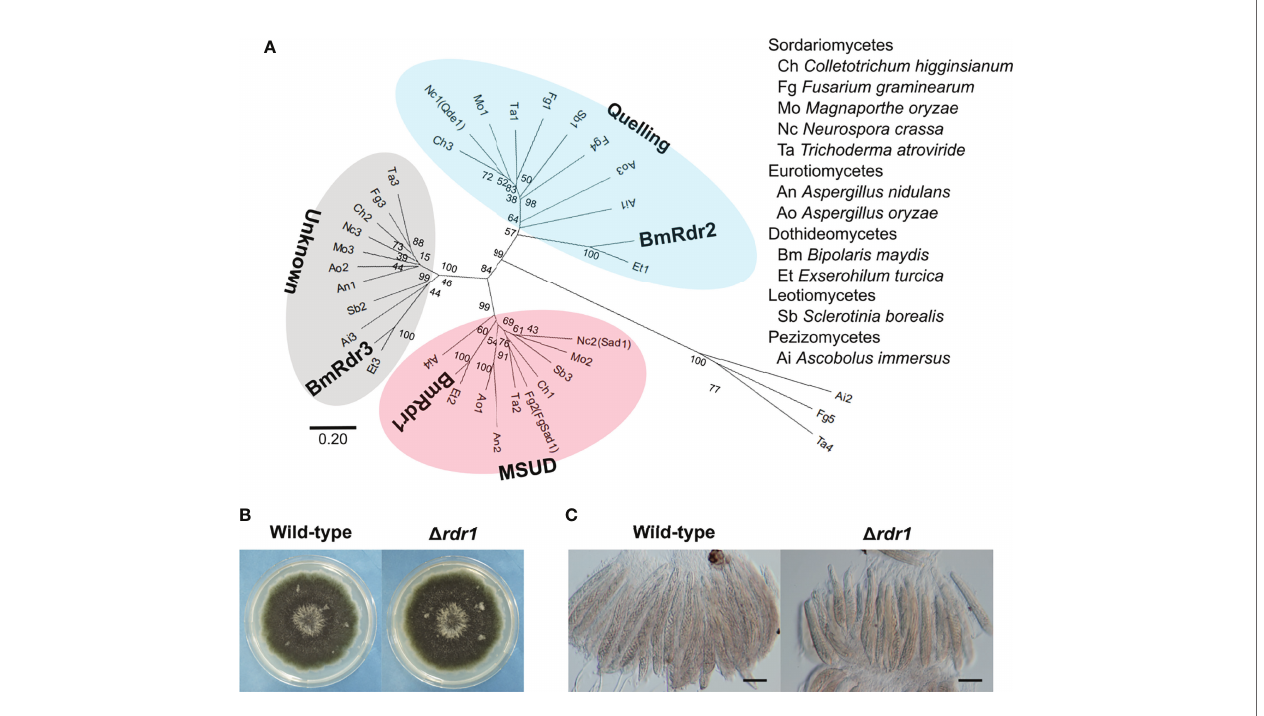
FIGURE 3 | Identi fi cation of the MSUD-related RdRP and generation of the RDR1 disruption mutant in B. maydis . (A) Phylogenetic analysis of the RdRP protein sequence. A neighbor-joining tree was constructed based on the conserved domain of the RdRP. The locus tags of proteins used in this analysis are listed in Supplementary Table S2 . The main three groups — quelling, MSUD, and unknown — are divided into different color zones. (B) Colonial morphology of the D rdr1 strain. The wild-type strain and the D rdr1 strain were cultured on CV8A for 7 days. (C) Asci and ascospores from the cross between the D rdr1 strain and the wild-type strain. The D rdr1 strain was crossed with the wild-type strain. After 4 weeks, resulting pseudothecia were harvested and dissected to observe the asci and ascospores. Bars : 50